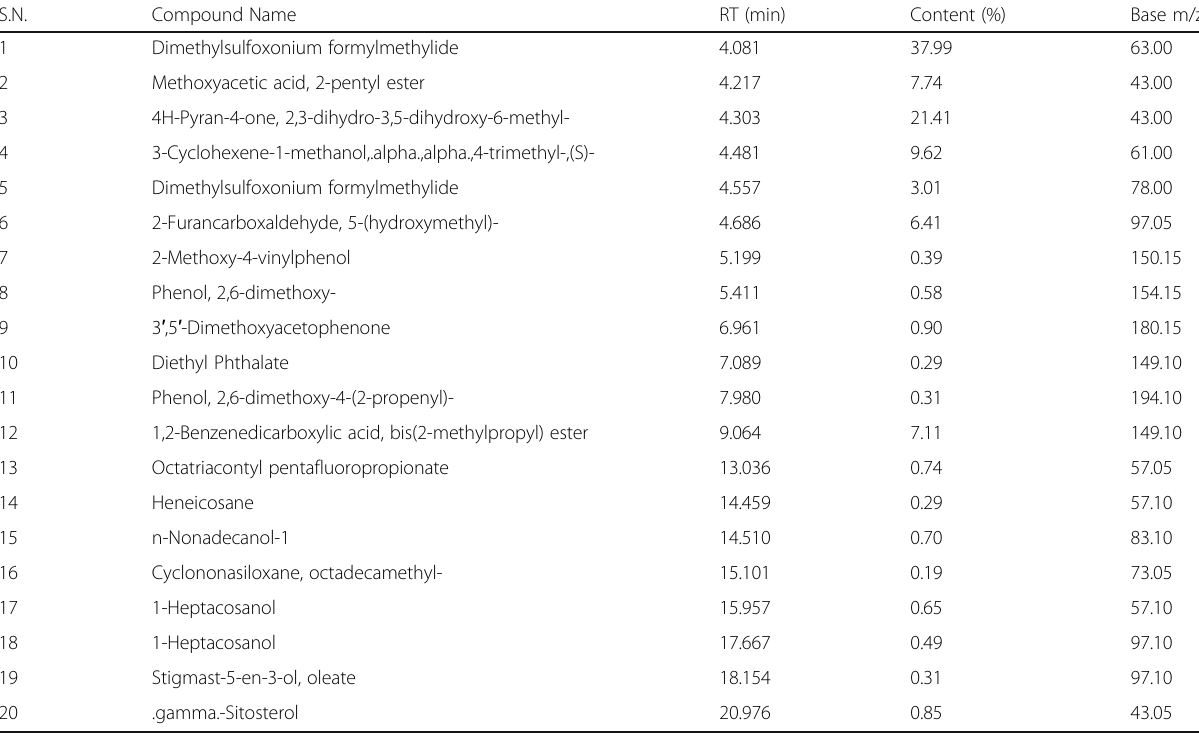
Table 2 Bioactive compounds detected in D. moniliforme methanol extract (DMM)